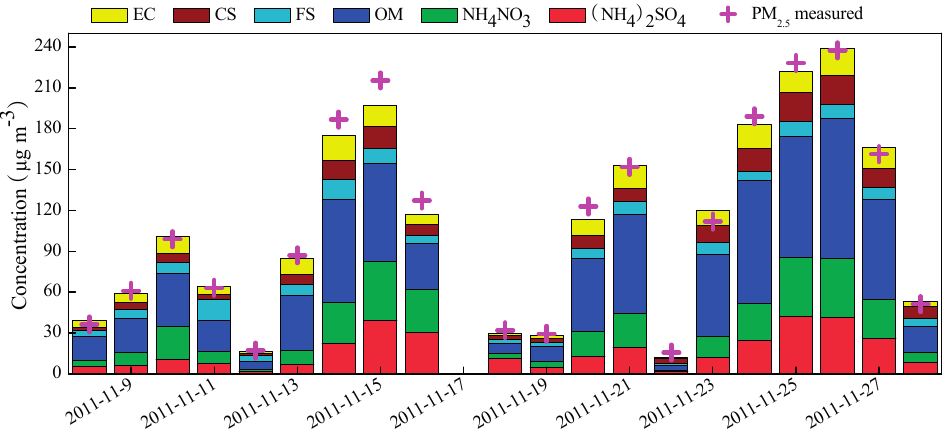
Figure 8. Daily variations of the reconstructed chemical composition in PM 2.5